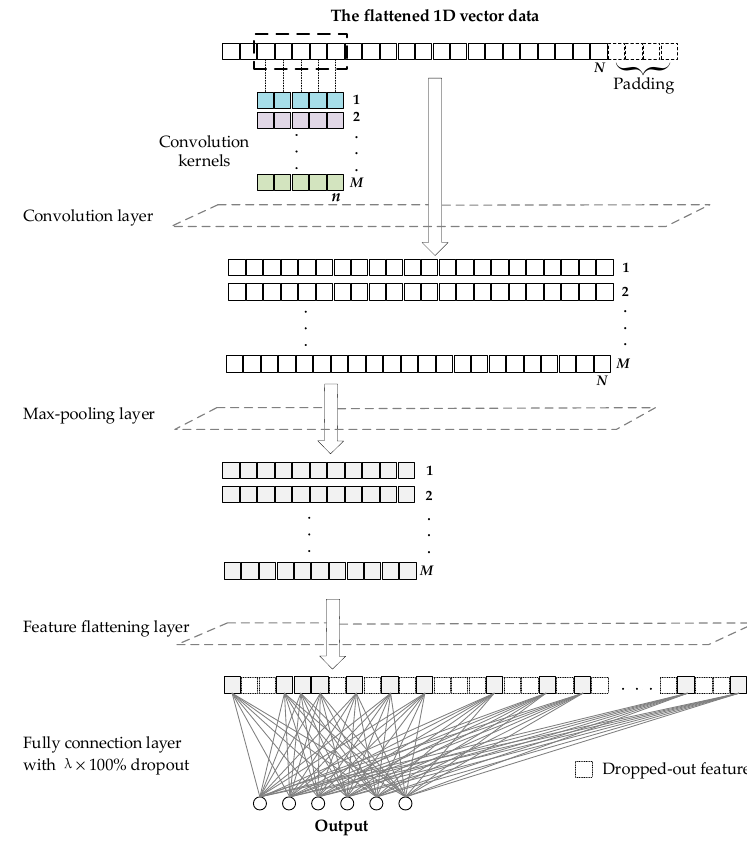
Figure 3. Illustration of the operations in different layers of the LwCNN. For clarification, duplicated layers and the activation layers are not included.